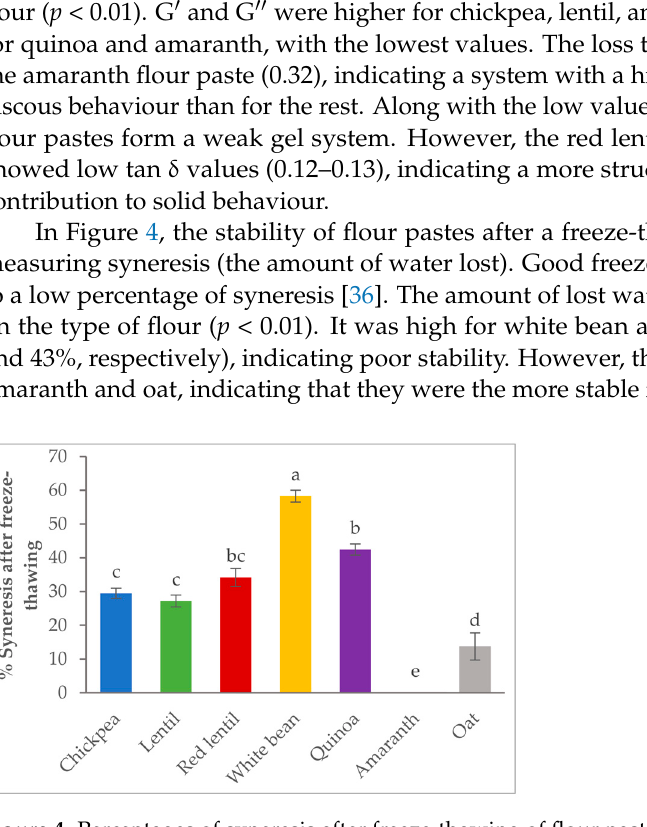
Table 6. Mean values of the Young’s modulus, hardness, and springiness of fl our gels. Standard deviation in brackets . Flours